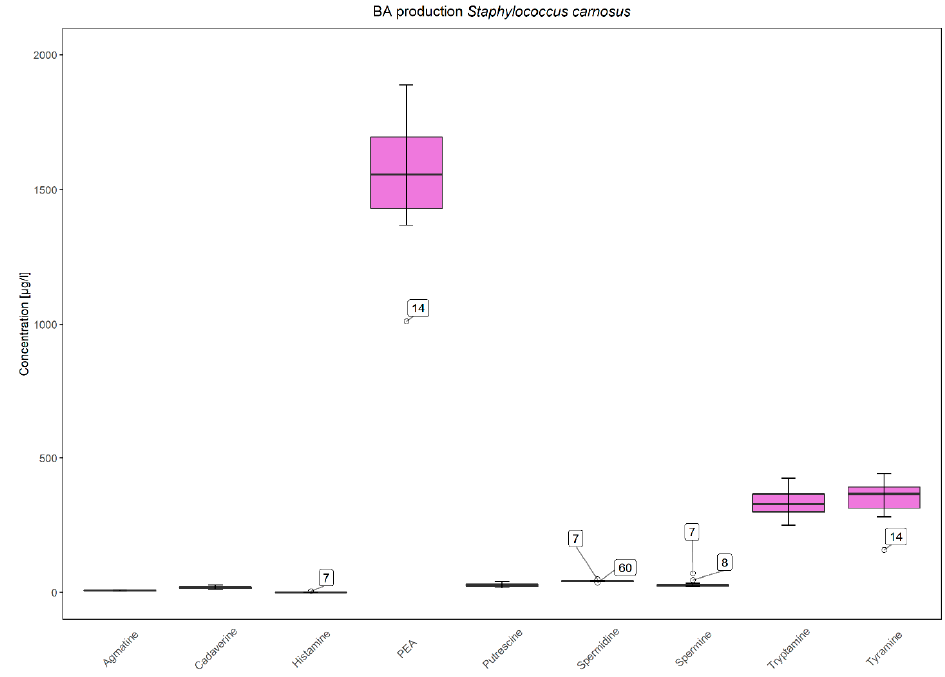
Figure 3. Average increase in biogenic amines (in µg/L) for all Staphylococcus carnosus strains (16) after 14 d of incubation in BHI broth. Outliers are indicated with the corresponding strain number (being S. carnosus IMDO-S7, IMDO-S8, IMDO-S14, and IMDO-S60).